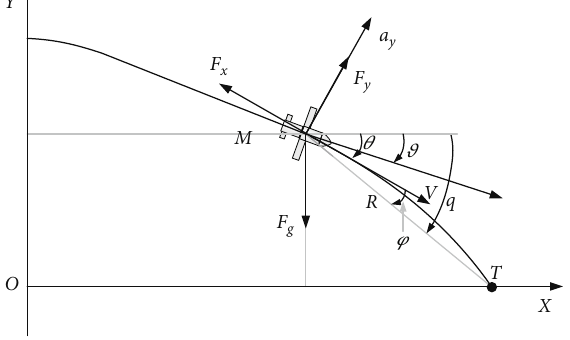
Figure 3: Missile-target geometric